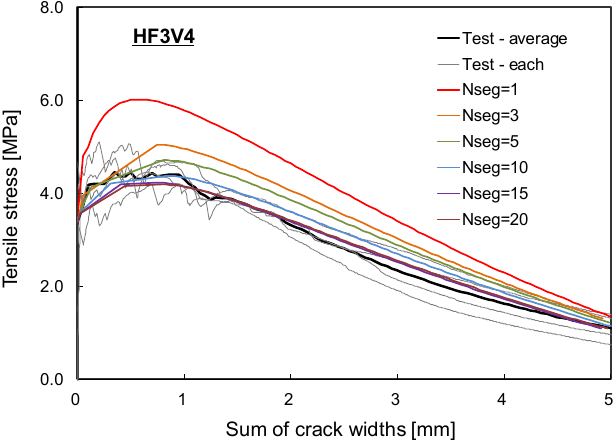
Figure 10. Comparison of the prediction and the test results for the tensile behavior. 369